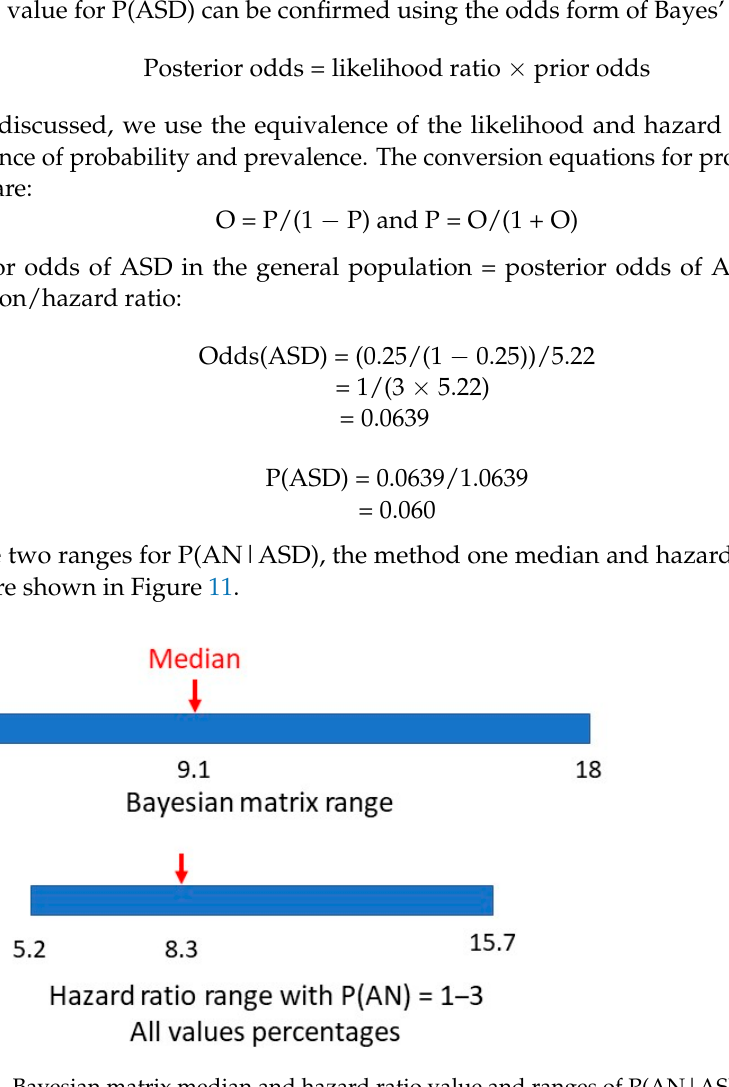
Figure 11. Bayesian matrix median and hazard ratio value and ranges of